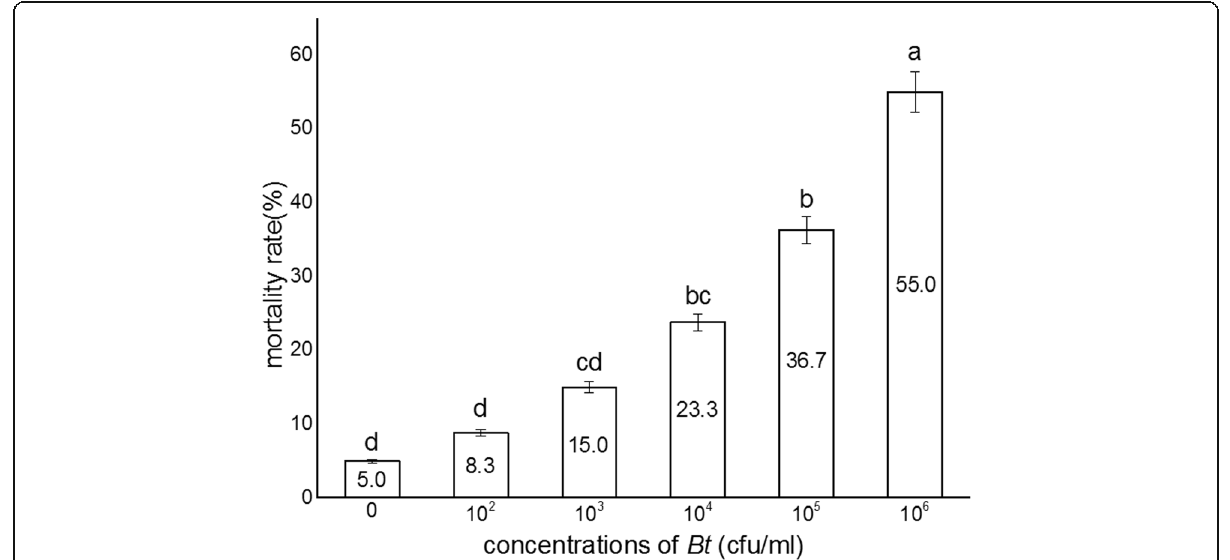
Fig. 1 Effect of Bt CAB109 on the mortality rate of S. exigua larvae